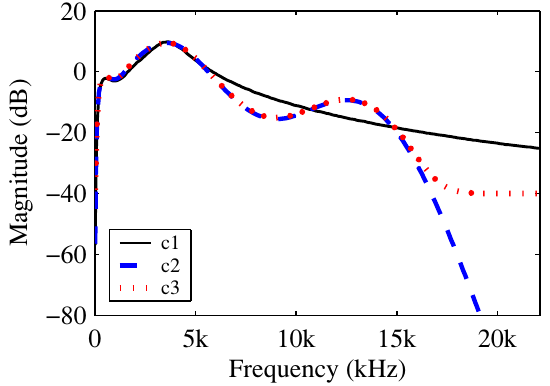
Figure 1. The weighting functions: modified E (c1), original F (c2) and modified F (c3) function.